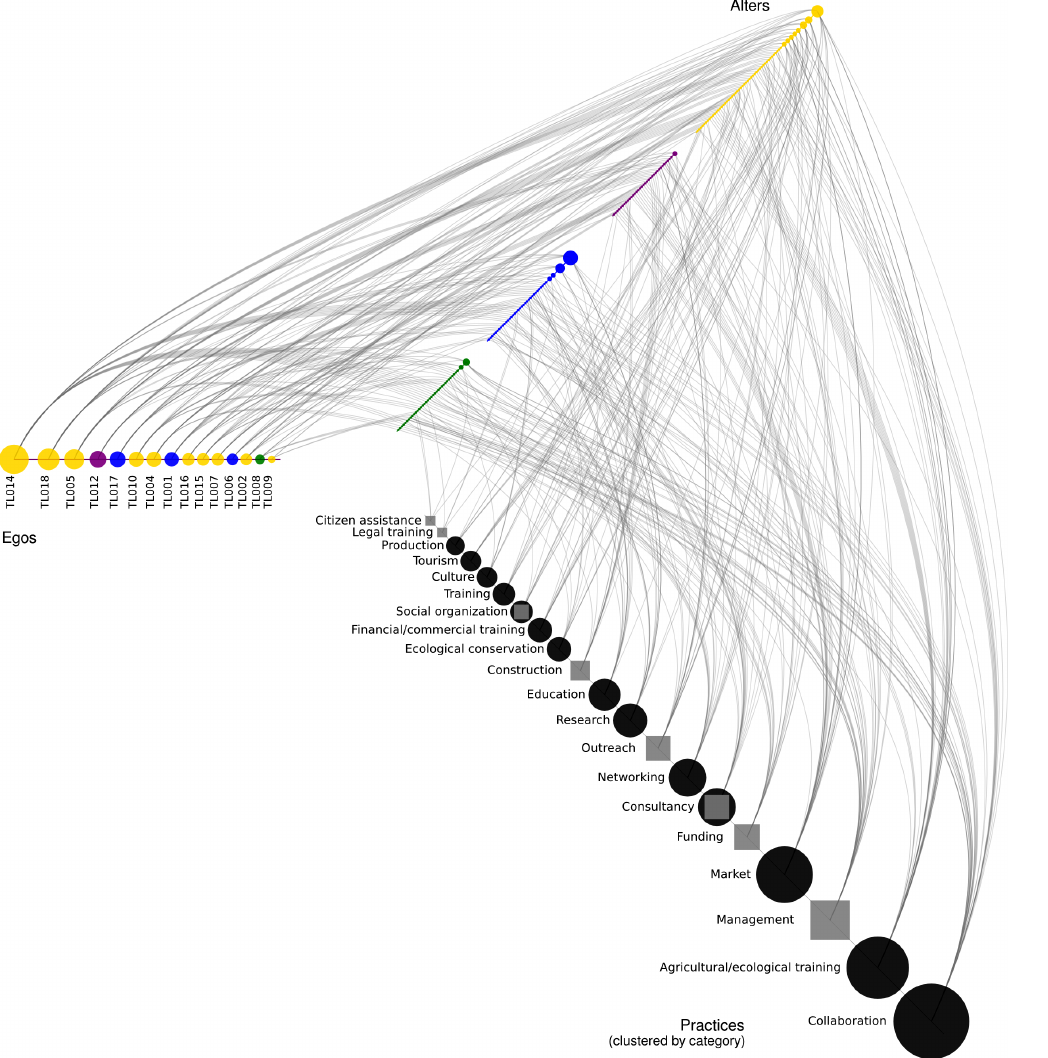
Fig. 7. Articulation of ego and action networks with the meta-narratives from cognitive maps. Egos and alters axes: yellow = civil society, blue = academia, green = government, purple = private sector. Practices axis: practices are clustered by category and ordered by in-degree; squares = Urban meta-narrative, circles = Agro meta-narrative, superimposed squares and circles = both Urban and